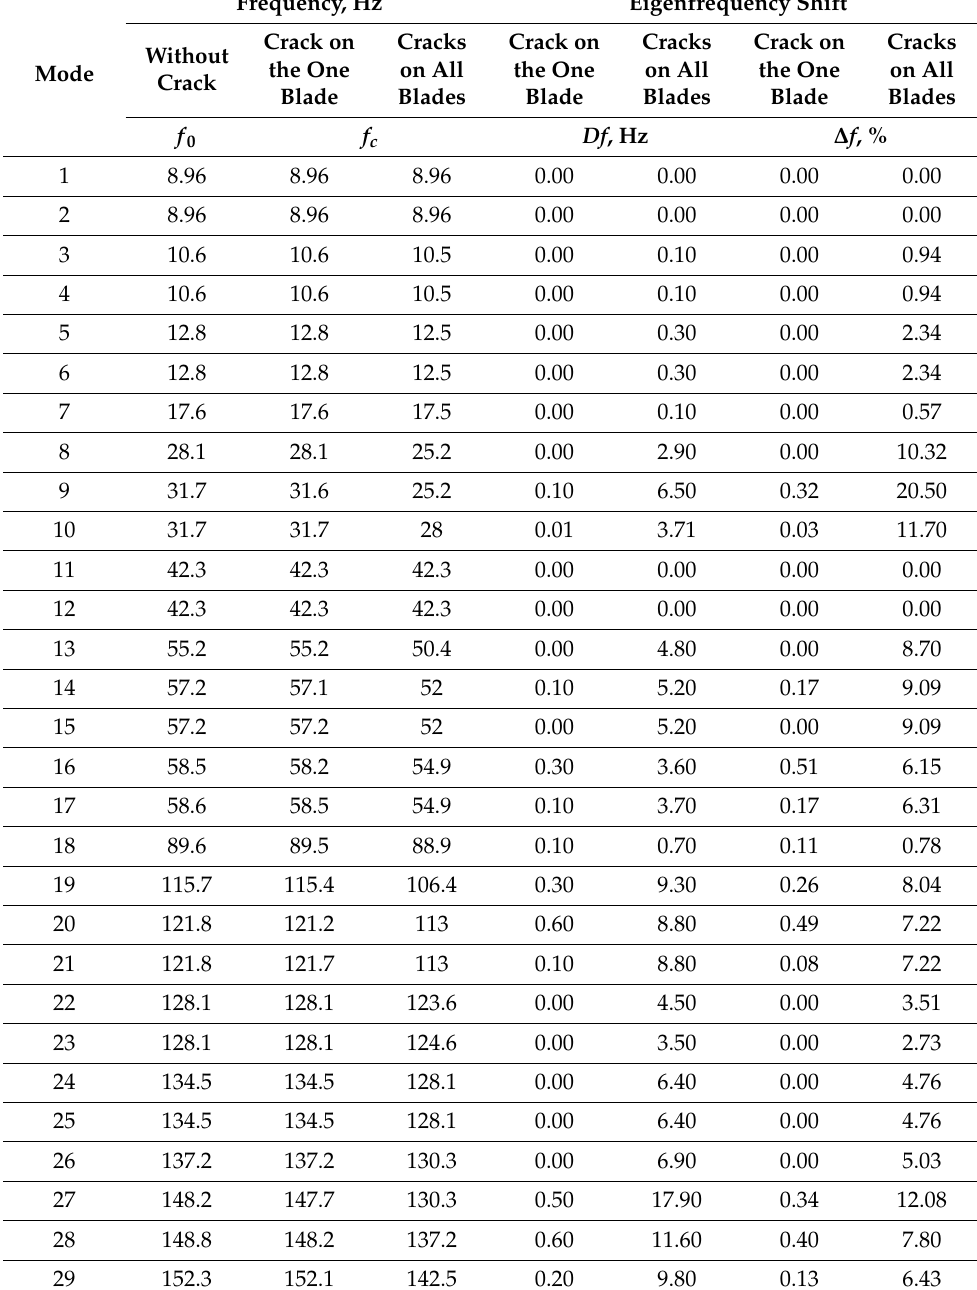
Table 2. The eigenfrequencies for the defect-free model and for the runner with cracks 340 mm long. Frequency, Hz Eigenfrequency Shift Cracks Crack on Cracks Crack on Cracks Crack on Without on All the One on All the One on All the One Mode Crack Blade Blades Blade Blades Blade